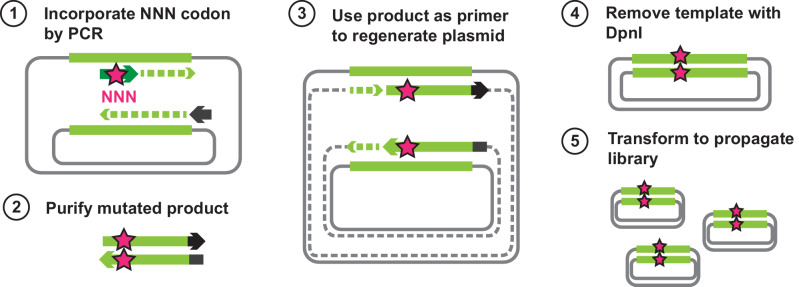
Outline of steps for generating all single amino acid variants of VIM-2.The wtVIM-2 gene is encoded on a plasmid, and the first step is to extract the gene using a PCR. The forward primers carry an ‘NNN’ mutation that is in frame with a specific codon of the wtVIM-2 gene, and all products will have a randomly mutated codon at that position. The mutated products are purified and used as primers to extend the rest of the plasmid using the same wtVIM-2 plasmid as the template, giving rise to the mutant VIM-2 plasmid library; the plasmid has a nick in both strands at the 5’ end, but can anneal to each other to become circular. As a final clean up step, the second PCR products are digested with DpnI for 1 hr at 37°C to remove the wt template. The purified library is then transformed into E. coli for propagation and subsequently purified.